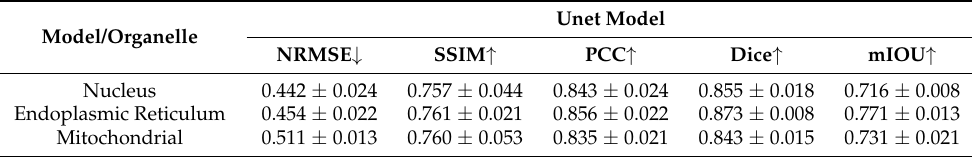
Table 3. Comparison of quality measures for label-free prediction results with the Unet model. Here, ↓ indicates that the lower the index value, the better the performance; ↑ indicates that the higher the index value, the better the performance of the